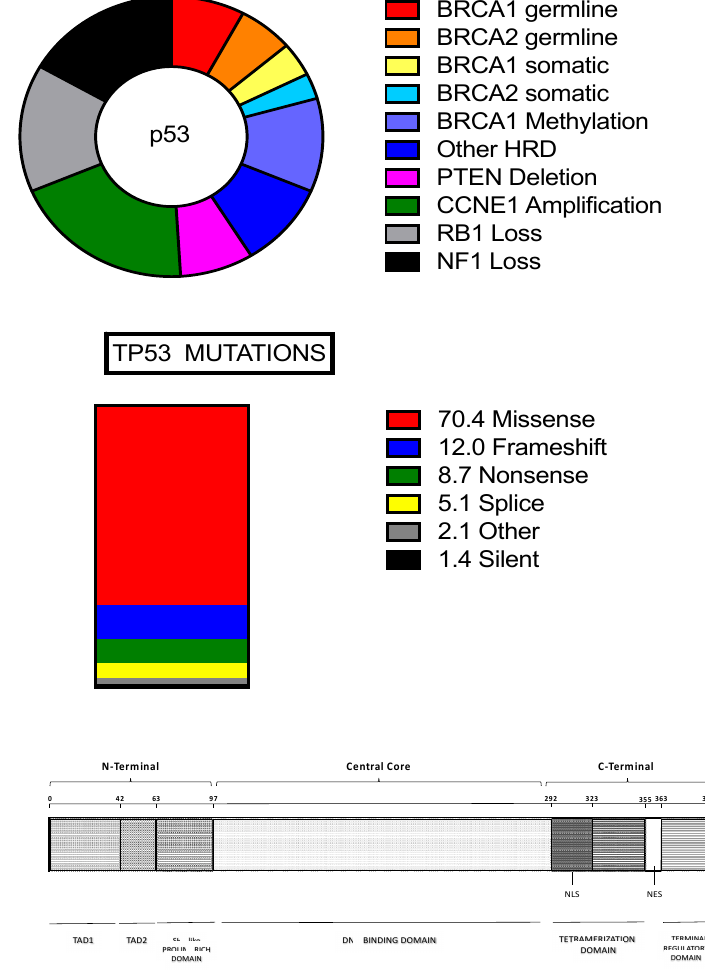
Figure 1. ( Top Panel ): Mutational spectrum of high-grade serous ovarian cancer (HGS-OvCa). In the figure are reported some of the recurrent genetic abnormalities observed in HGSOC. In the middle of the circle of the figure, TP53 mutations are indicated, occurring in virtually 100% of patients; ( Middle Panel ): Different types of TP53 mutations and their percentages in HGS-OvCa; ( Bottom Panel ): Structure of TP53 protein: the different structural and functional domains of the protein are reported. TAD1 and TAD2: Tans Activation Domains 1 and 2; NLS: Nuclear Localization Signal; NES: Nuclear Esportation Signal.